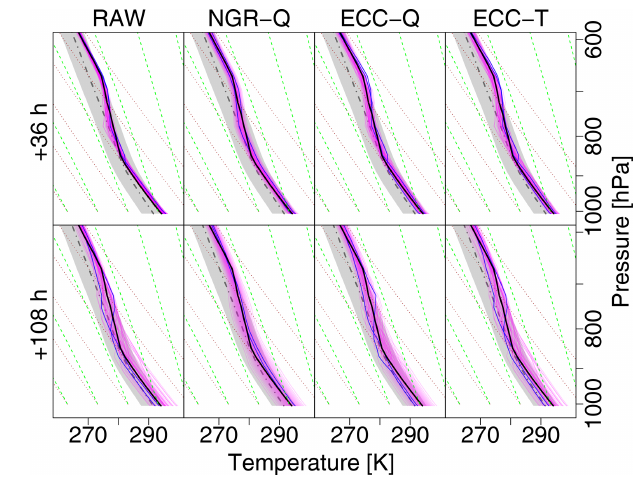
Figure 10. As in Fig. 7 but for a summer case of 2 June 2017, 12:00Z and lead times of + 36h (first row) and + 108h (second row), respectively.